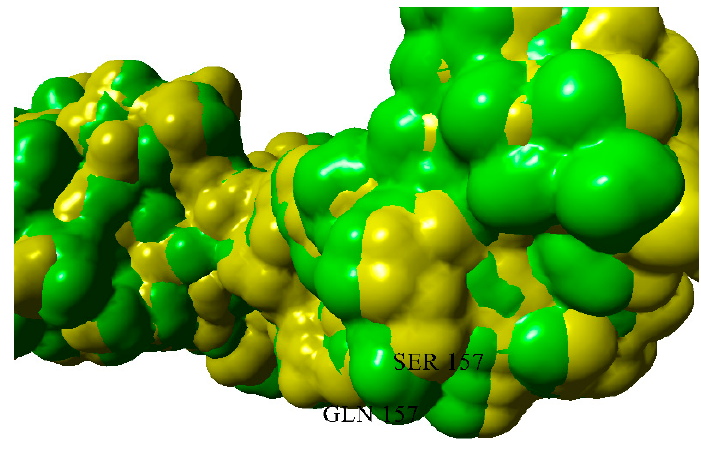
Figure 14. Solvent-accessible surfaces of wild-type BIF (yellow) and S157Q mutant (green). The presence of fibrils in addition to AFM observations was confirmed by analysis of birefringence of samples incubated for a month at 37 °C in polarized light after Congo red staining, by thioflavin T (ThT) (Figure 15) and Congo red (CR) spectroscopic assays and by analysis of resistance of samples to 2% SDS in gel-electrophoresis (Table A1).